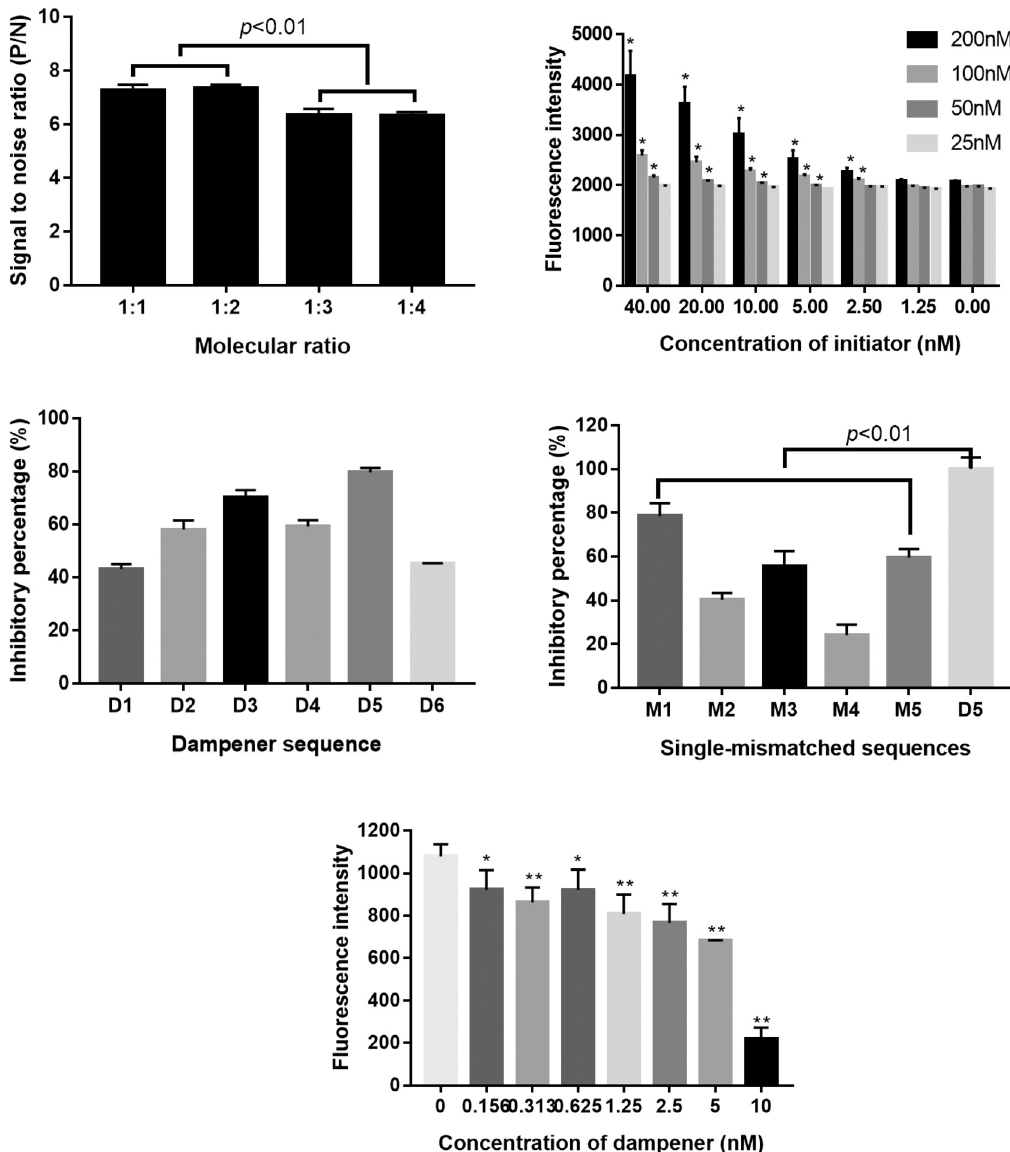
Fig 2. Optimization of the HCR with different parameters. A) Optimization of the molar ratios of H1:H2–4. B) Determining the LOD of initiator I1 at different concentrations of hairpins. � p < 0.05 vs control added with 0 nM initiator. C) Inhibitory efficiency of different dampeners. D) E) The inhibitory effect of dampener D5 in the presence of I1 (2.5 nM). � p < 0.05 or �� p < 0.01 vs control added with 0 nM dampener. Four repeats were used for all tests (N =